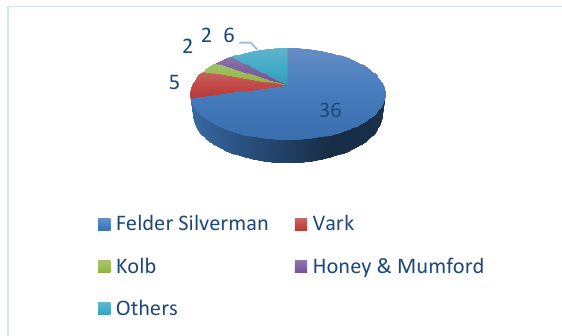
Figure 1. Learning style theories applied in adaptive learning